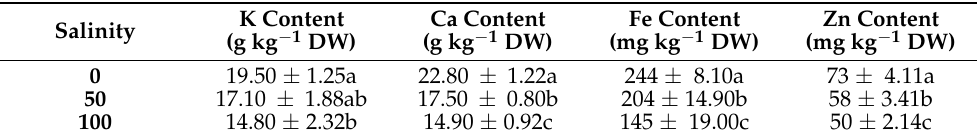
Table 9. Comparison of means for the effects of salinity on K, Ca, Fe, and Zn content in Portulaca oleracea plants. Salinity